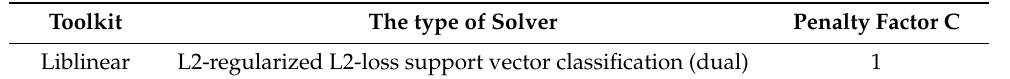
Table 7. The parameters of liblinear toolkit.